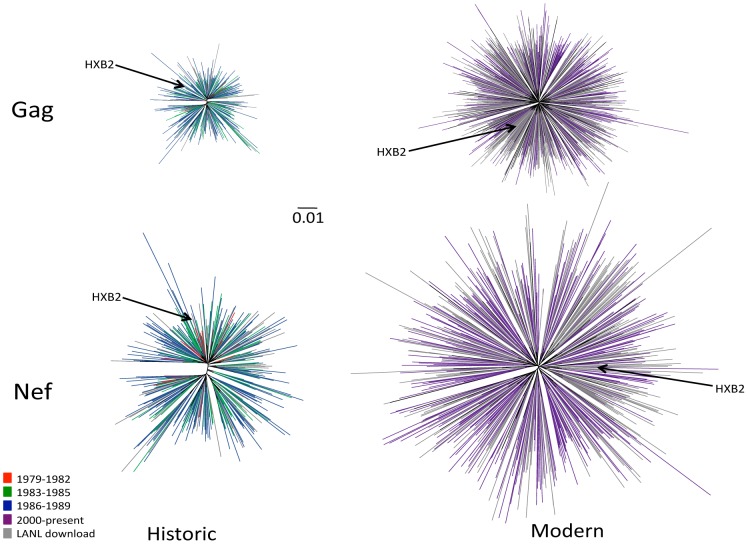
Diversity of North American Gag and Nef sequences from historic (1979–1989) and modern (2000+) eras.Unrooted Maximum likelihood phylogenetic trees, drawn on the same distance scale, are shown for historic Gag (upper left), historic Nef (lower left), modern Gag (upper right) and modern Nef (lower right). Phylogenies are star-like, with Nef exhibiting greater diversity than Gag, and modern trees exhibiting greater diversity than historic ones. Cohort sequences are colored by sampling era: red (1979–1982), green (1983–1985), blue (1986–1989) and purple (2000+); North American sequences retrieved from the Los Alamos (LANL) database are in grey. Included in each tree is the HIV subtype B reference strain HXB2, shown in black and indicated with an arrow.